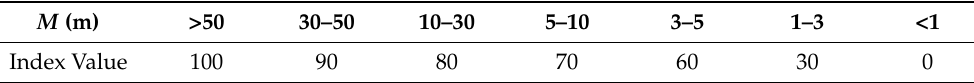
Table 4. Aquifer thickness ( M ) scoring criterion.